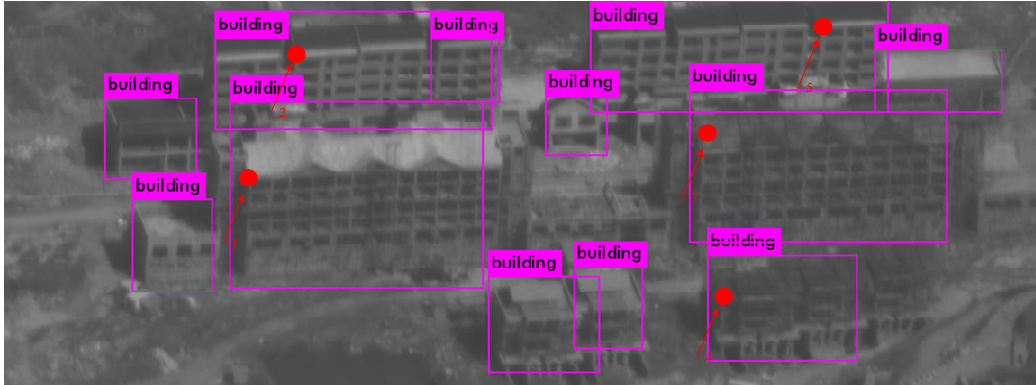
Remote Sens. 2019 , 11 , x FOR PEER REVIEW Figure 15. Schematic diagram of the building detection results 1. Figure 15. Schematic diagram of the building detection results 1.